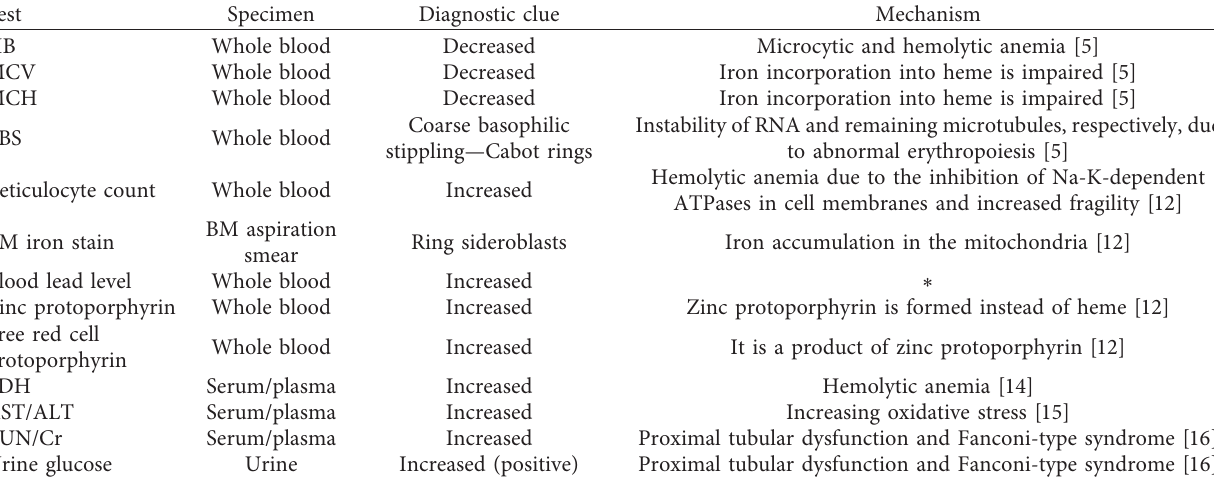
Table 2: Change of different laboratory tests in lead